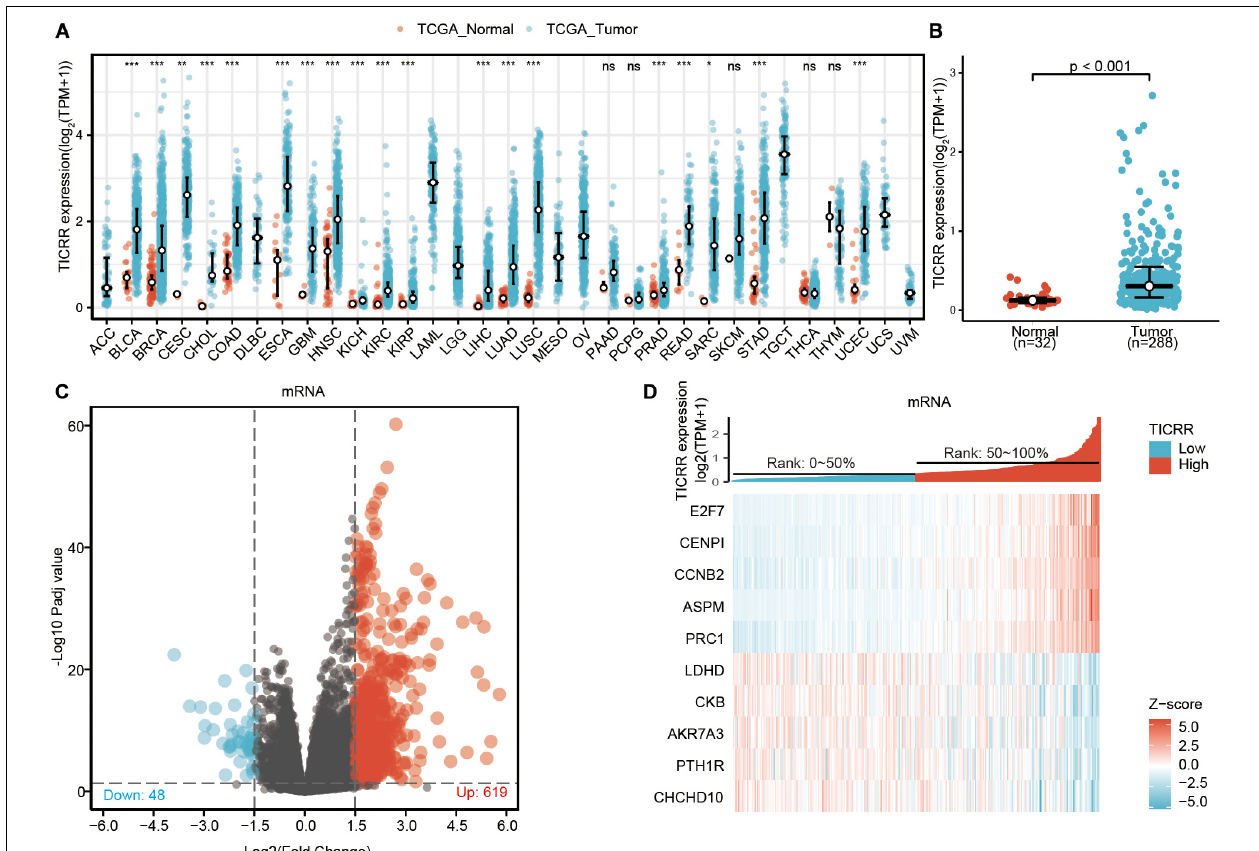
FIGURE 1 | Differential mRNA expression profiles in papillary renal cell carcinoma (PRCC) patients stratified by TICRR levels. (A) The comparison of TICRR expression between tumor and pericarcinous tissue in different types of cancers based on TCGA database. ns, P ≥ 0.05; * P < 0.05; ** P < 0.01; *** P < 0.001. (B) TICRR expression is higher in PRCC tumors than pericarcinous tissue. Based on the median TICRR level, 288 PRCC patients from The Cancer Genome Atlas –Kidney Renal Papillary cell carcinoma Project (TCGA-KIRP) were stratified into high- and low- TICRR expression groups. Shown are expression profiles of mRNA in two groups; and data are presented by volcano plots (C) and heatmaps (D)